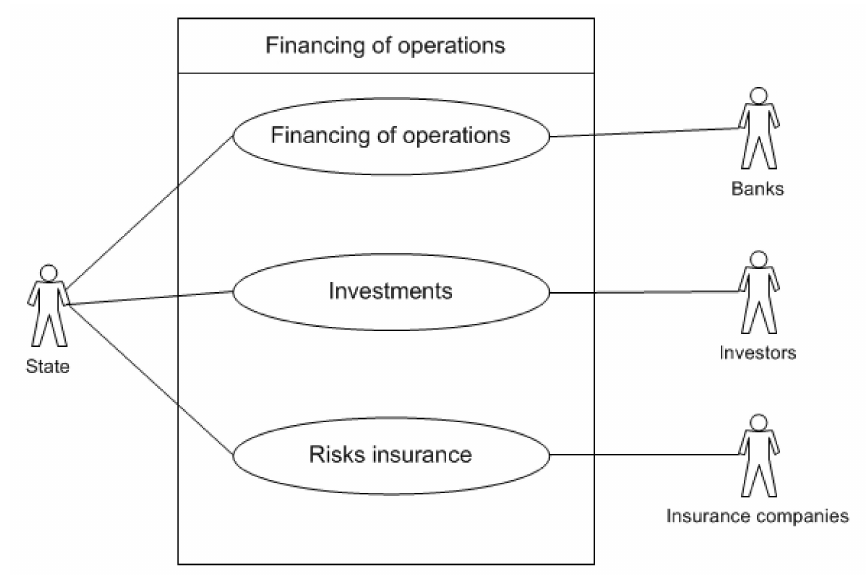
Figure 4. Financing of